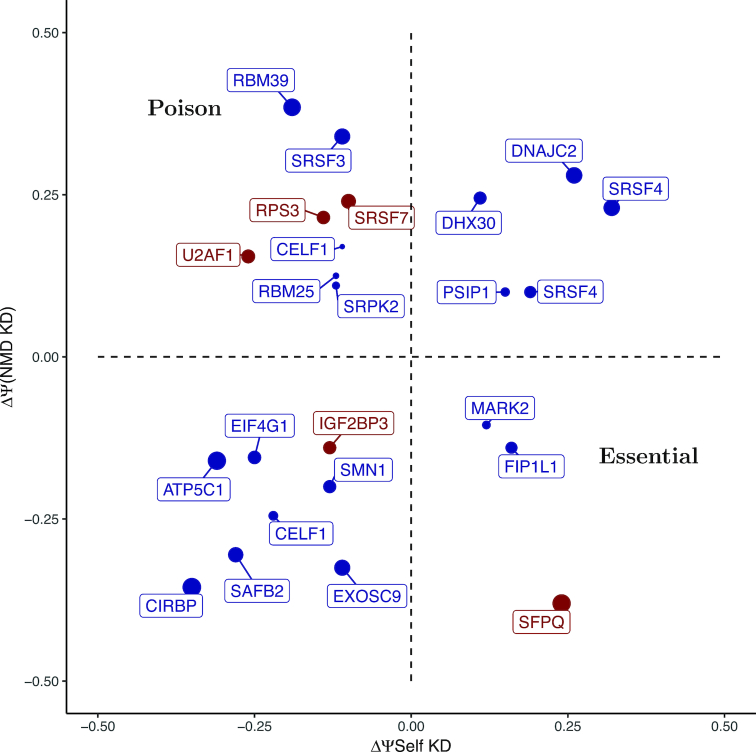
Bivariate analysis of significant splicing changes under UPF1/XRN1 co-depletion (y axis) vs. shRNA-KD of RBP itself (x-axis). Only genes with |ΔΨ| ≥ 0.1 in both axes are plotted. Genes with at least one cognate eCLIP peak are shown in red. The size of the dot is proportional to the log10 of the combined q-value, which is equal to the sum of −log10(q)-values for NMD depletion, shRNA-KD of the host RBP, and the respective eCLIP.